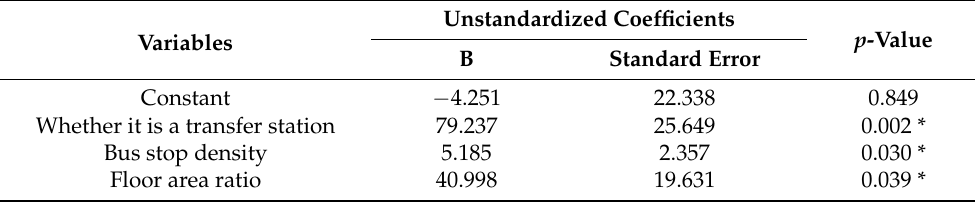
Table 4. Performance of stepwise regression on school commuting flow.